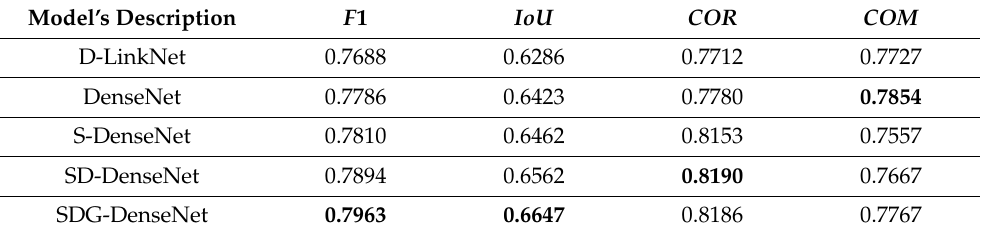
Table 3. Results of the Massachusetts Roads Dataset of different models. The bold font indicates the optimal value under the current evaluation